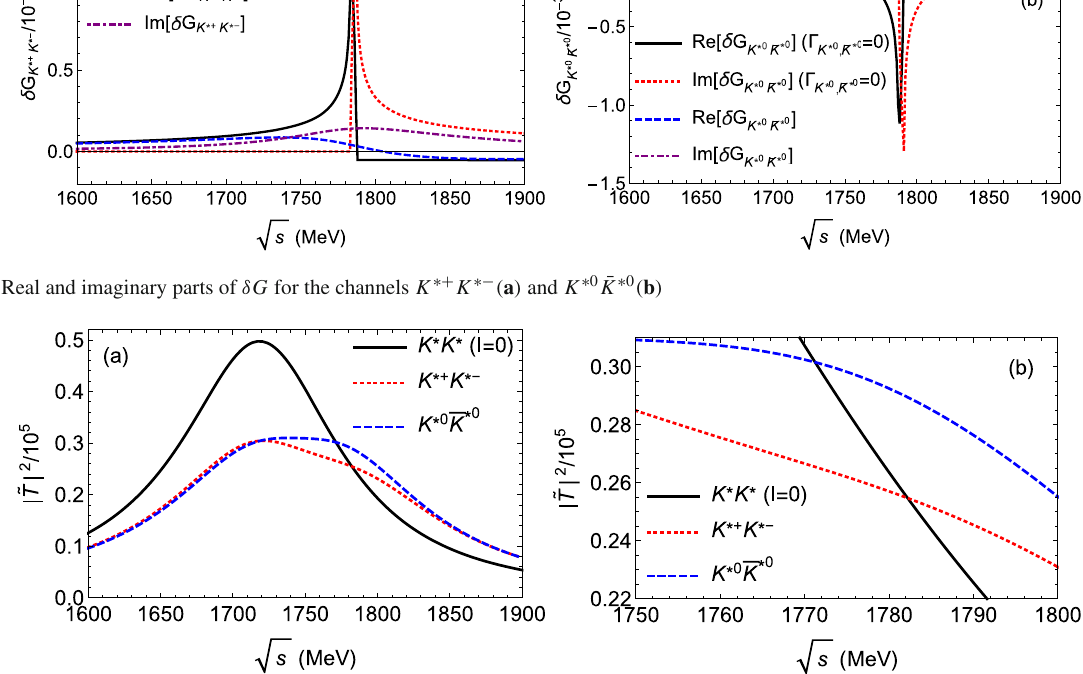
the δ G ’s are small but this must be gauged versus G, which